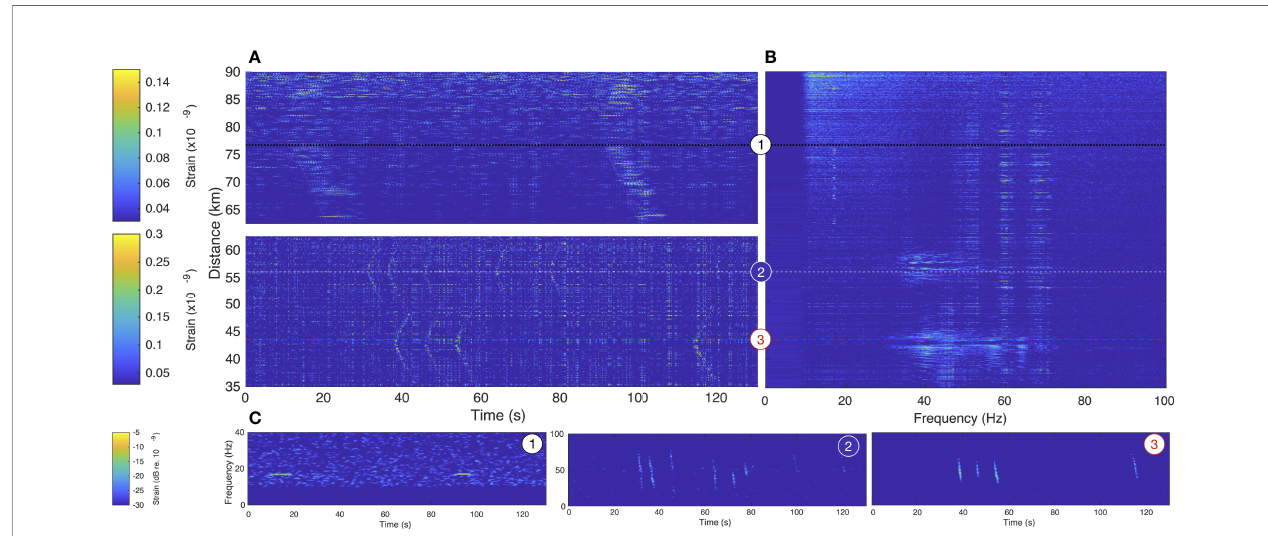
FIGURE 4 | Vocalizing baleen whales recorded simultaneously at three different locations along the Svalbard DAS array. (A) Spatio-temporal ( t - x ), (B) Spatio- spectral ( f - x ) and (C) Spectro-temporal (spectrogram) representations of a 130 s-long portion of recording from June 26, 2020 at 052440UTC, between 35-90 km of fi ber optic cable. Each whale position (around 76.5 km, 57.5 km and 44.2 km) is given a number 1-3, to facilitate panel